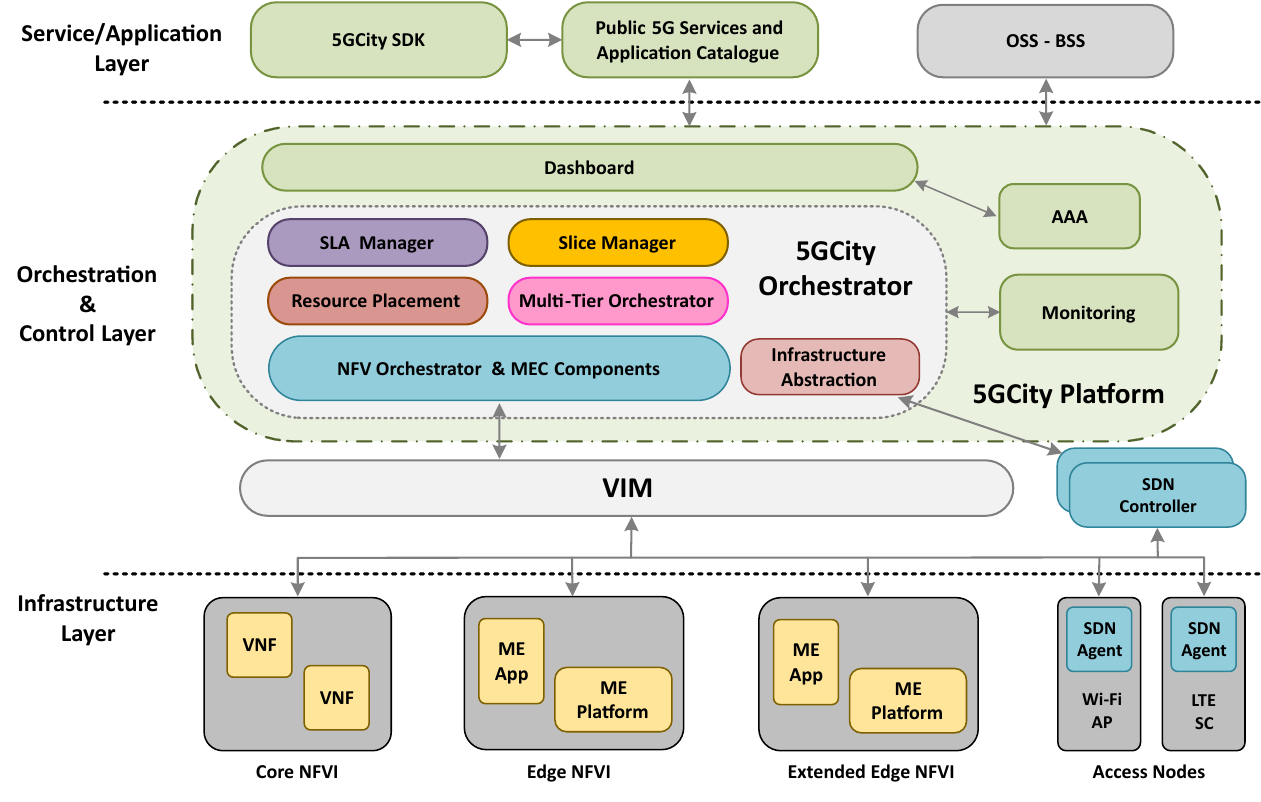
Figure 1. Neutral host